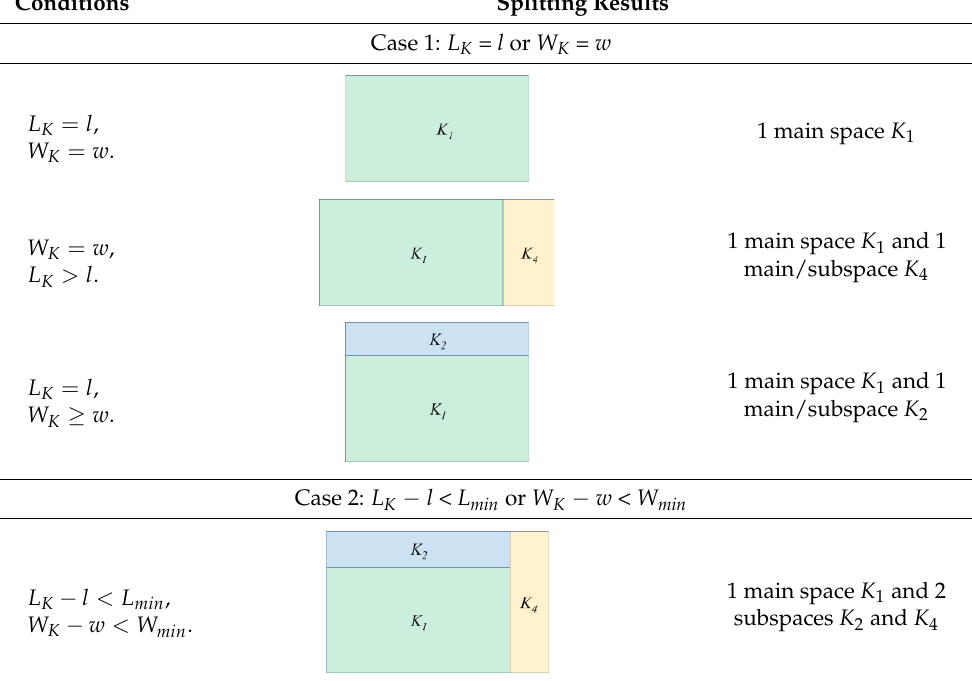
Table 2. The splitting results. Conditions Splitting Results Case 1: L K = l or W K = w